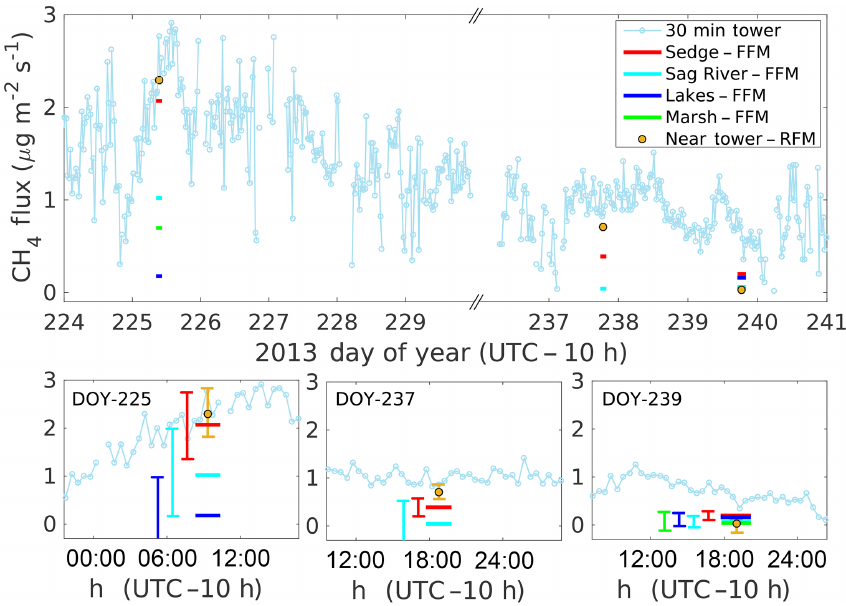
Figure 4. Methane fluxes measured from the flux tower compared with fluxes measured by the FOCAL system. Tower methane fluxes (top plot) are 30min means plotted versus day of year. The flights (13.09:30, 25.18:00, and 27.19:00 on DOY 225, 237, and 239, respectively) each included repeated passes near the tower. The orange circle gives the mean over these passes of the RFM-determined 3km flux centered nearest the tower. Fluxes by FFM were aggregated by surface class over the whole flight. The length of the line along the time axis represents the period over which the data were taken, typically 1.5h. Lower panels show details for each flight day, labeled by day of year (DOY), with vertical bars showing the 95% confidence interval based on bootstrap analysis. Bars are offset along the x axis for